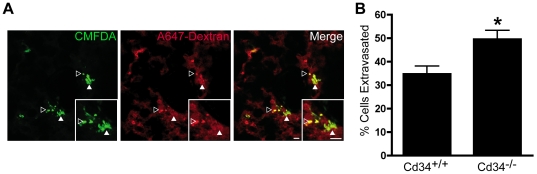
Increased tumor cell extravasation in Cd34−/− animals.A, CMFDA-labeled B16F1 cells (green) were coinjected i.v. with fluorescent dextran (red) and lungs were removed after 4 hours, fixed, sectioned and imaged. Representative sections are shown. Tumor cells were quantified as extravasated (green – solid arrows), or within the microvasculature (yellow – hollow arrows). Scale bar, 50 µm, inset = 2×zoom. B, Proportion (%) of tumor cells extravasated per section (n = 5 lungs per genotype, >5 sections per lung, *represents p<0.05; Error bars = SEM).